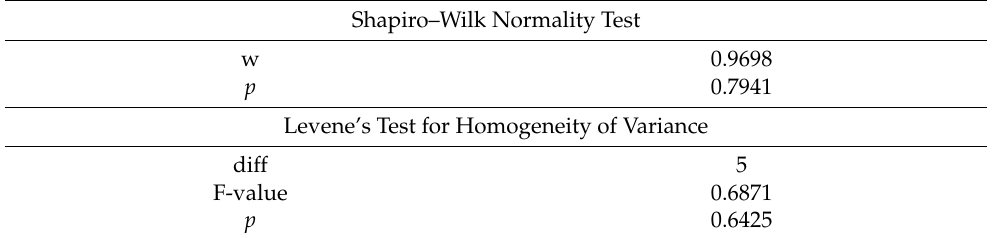
Table 14. Shapiro and Levene’s test result (PT).